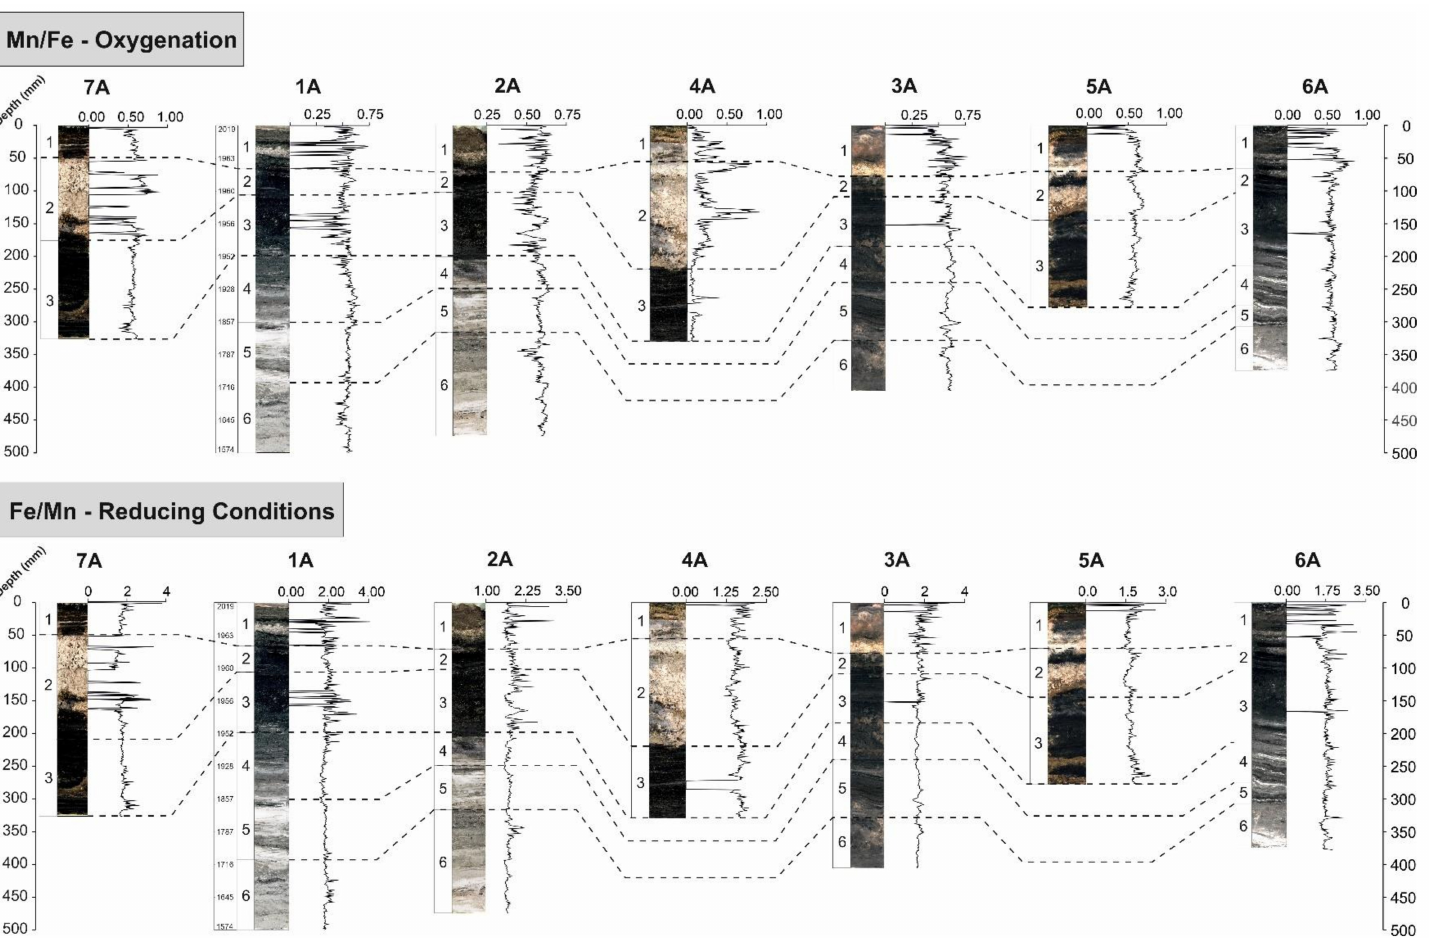
Figure 8. Figure illustrating spatio-temporal variations in geochemical proxies typically used for determination of oxygenation [63] and anoxia and lowered oxygen levels [64]. Increasing values indicate increasing oxygenation and reducing conditions for each